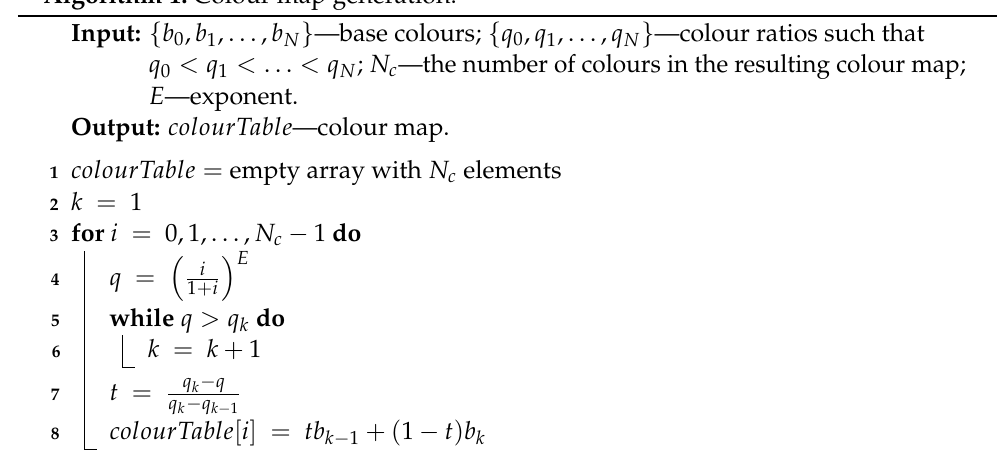
Algorithm 1: Colour map